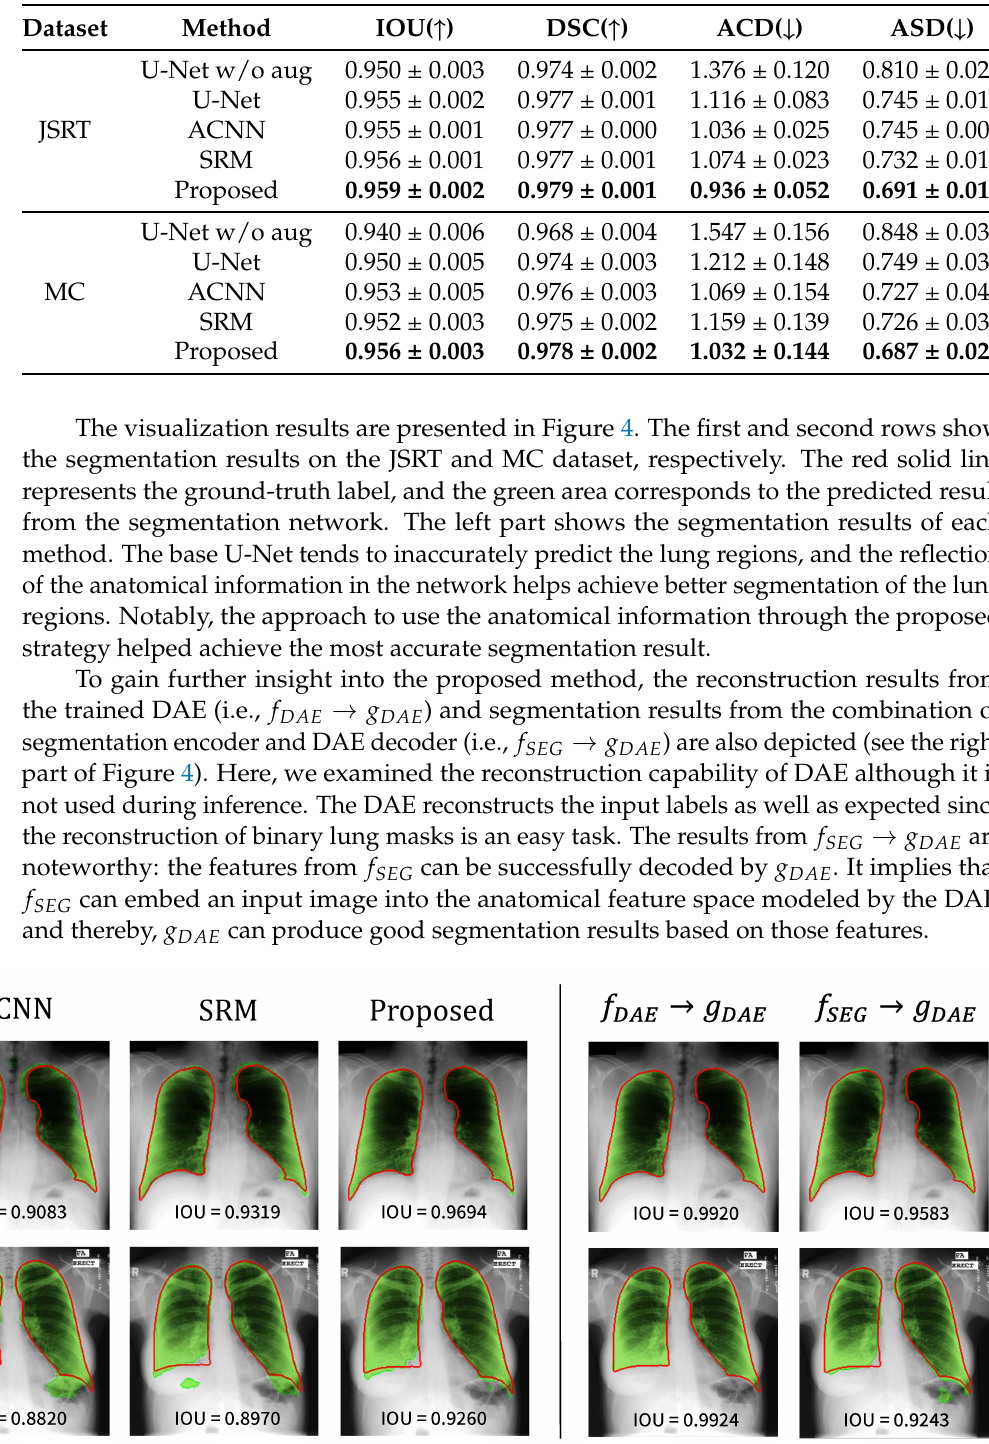
Table 3. Comparison of lung segmentation test performance. The means and standard deviations over five runs are reported. For each dataset, the best result is shown in boldface.